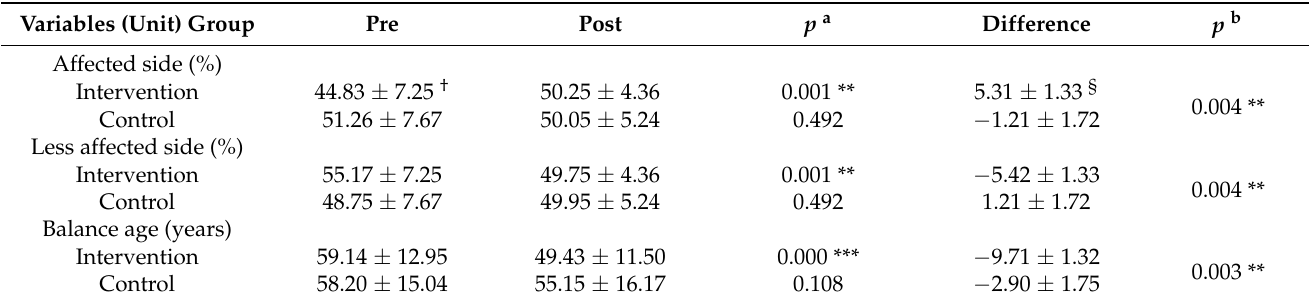
Table 2. Changes in the symmetricity of weight distribution and balance